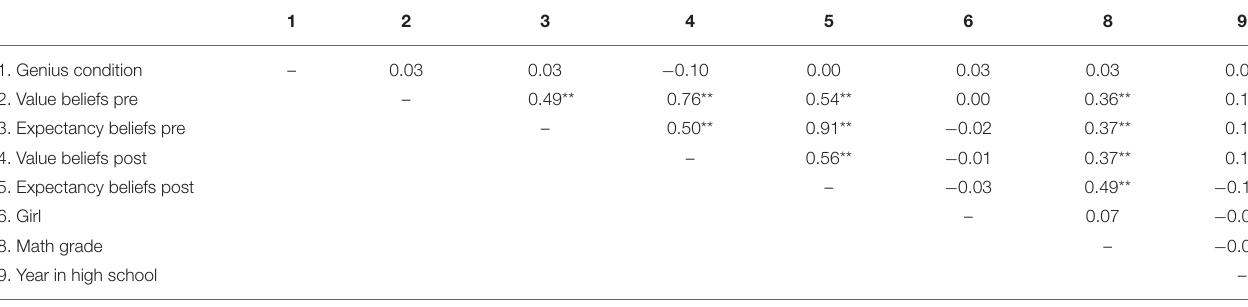
TABLE 1 | Bivariate correlations across major variables.